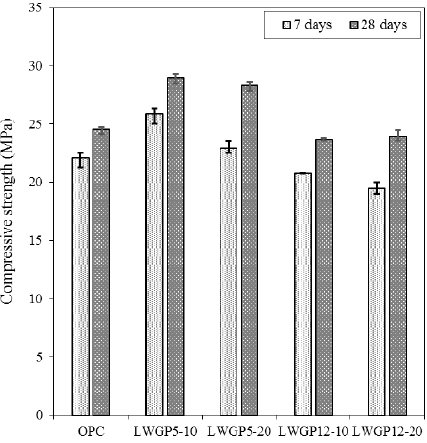
Figure 6. Compressive strength results of the LWGP concrete flumes.